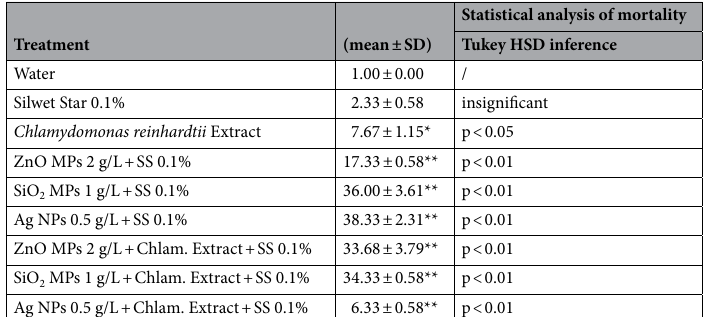
Table 1. Statistical analysis of T. molitor mortality expressed as the mean ± SD with Tukey HSD inference.